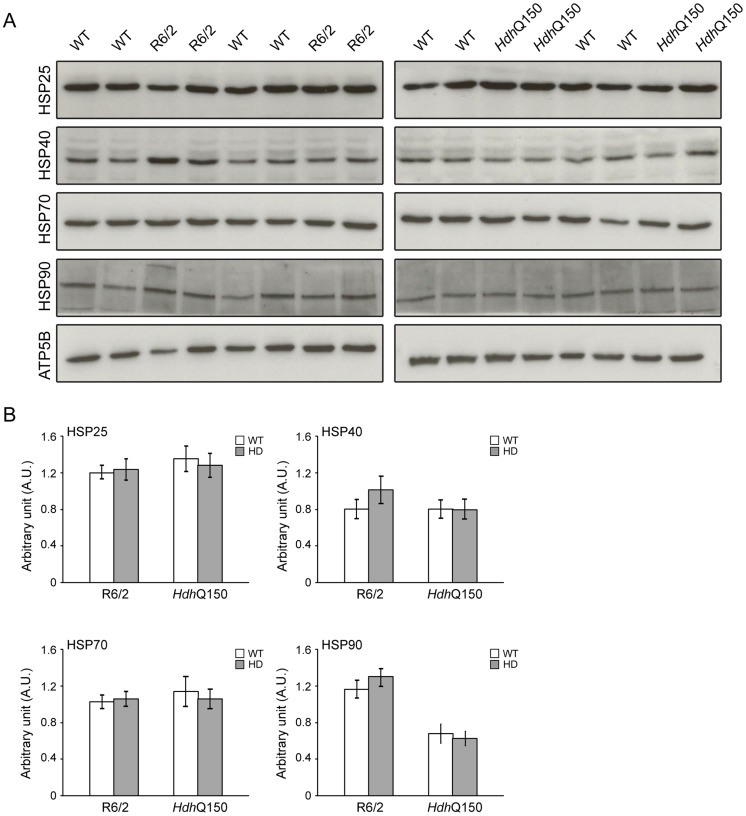
Heat shock proteins are not dysregulated in the murine HD hearts.(A) Western blots of heat shock proteins in 14-week-old WT and R6/2 mice (left panel) and in 22-months-old WT and HdhQ150 mice (right panel). (B) Relative expression of HSP25, HSP40, HSP70 and HSP90 in 14-week-old WT and R6/2 mice and in 22-months-old WT and HdhQ150 mice normalized to ATP5b by densitometry. Values are mean ± SEM (n = 4). Student's t test: *p<0.05, **p<0.01, ***p<0.001.